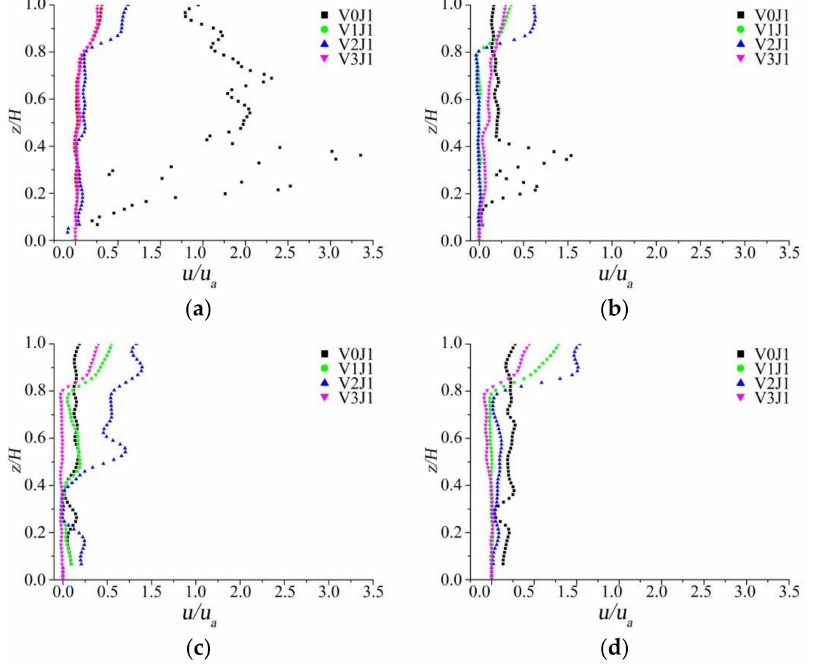
Figure 6. Vertical flow velocity distribution of transverse jets at the different positions x / D under different conditions. ( a )Velocity distribution along the vertical at x / D = 20; ( b ) Velocity distribution along the vertical at x / D = 25; ( c ) Velocity distribution along the vertical at x / D = 50; ( d ) Velocity distribution along the vertical at x / D =